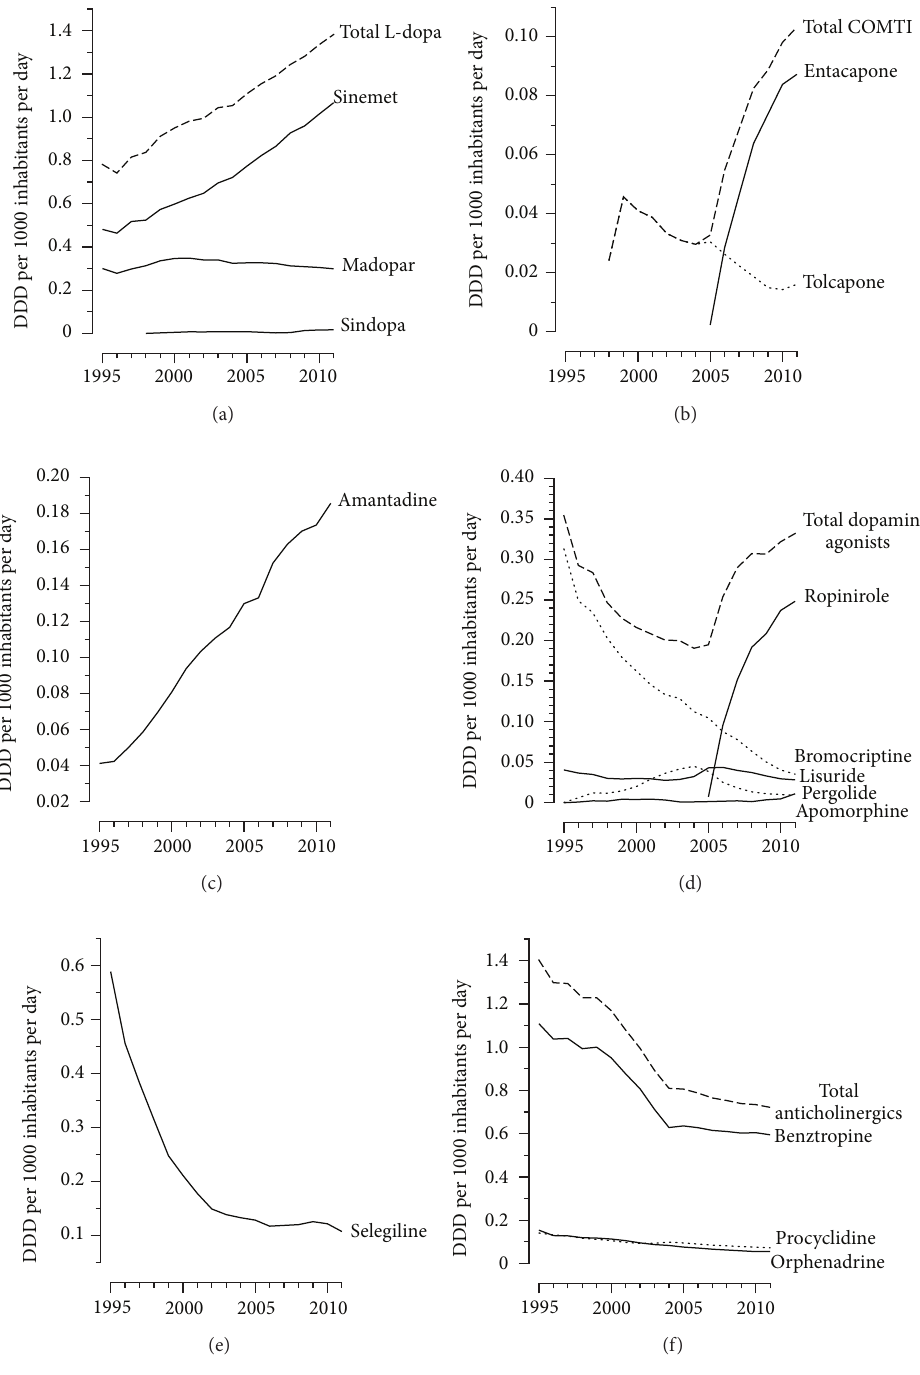
Figure 2: Change in volumes of individual antiparkinsonian agents by drug group. (a) Levodopa (L-dopa), (b) catechol-o-methyl transferase inhibitors (COMTI), (c) Amantadine, (d) dopamine agonists, (e) selegiline, and (f) anticholinergics. DDD defined daily